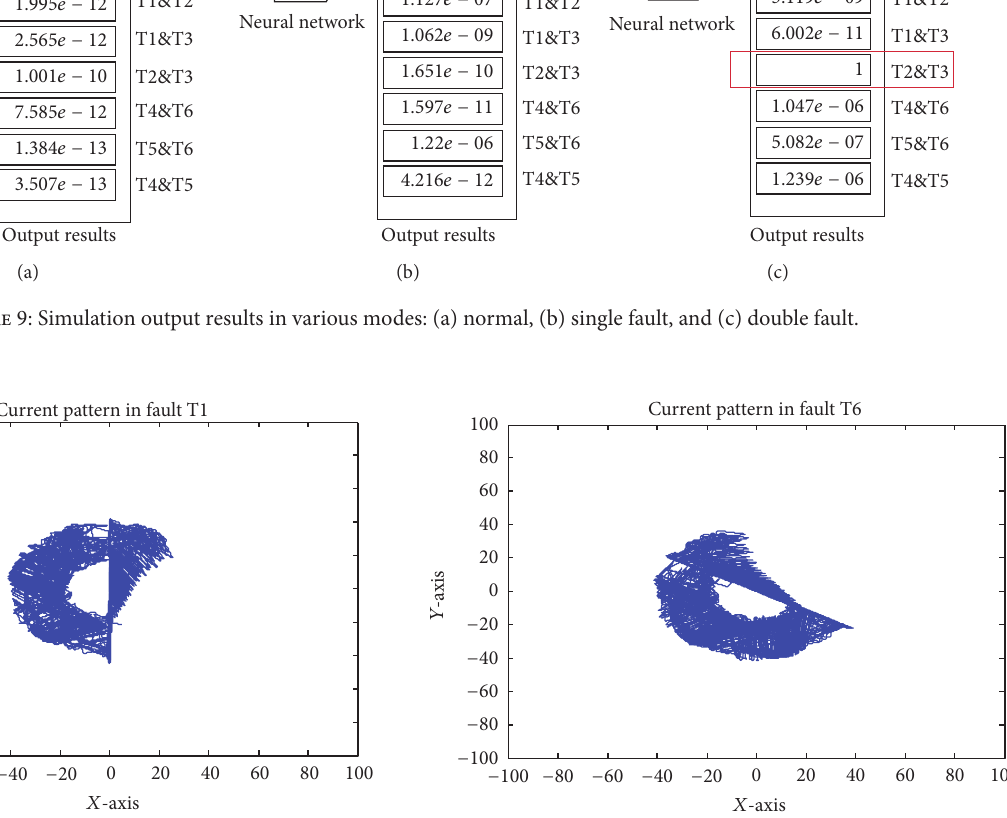
Figure 10: 𝛼 - 𝛽 transformed current pattern graph for system in single fault mode T1.